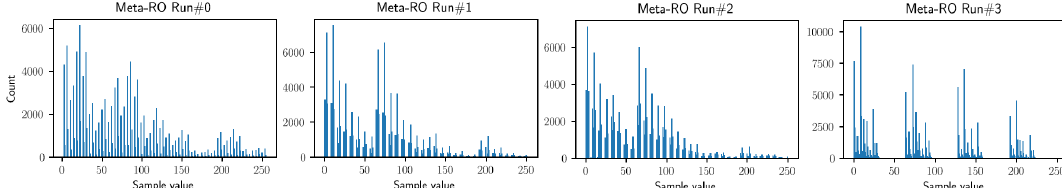
Figure 10. Output values histograms for eight parallel Meta-RO elements.